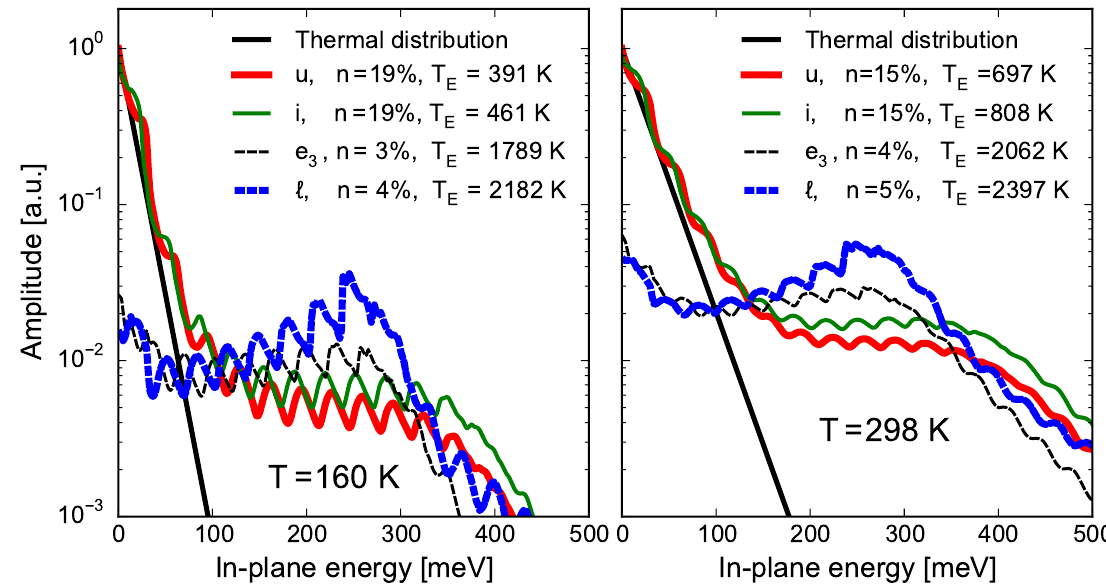
Figure 5. In-plane electron energy distribution for the upper lasing level (u), lower lasing level ( (cid:96) ), injector (i), and the most important extractor ( e 3 ) state. Results are shown at the design lasing field (82 kV/cm) for lattice temperatures of 160 K (left) and 298 K (right). The solid black line shows the corresponding thermal equilibrium distribution e − E k / k B T for comparison. For each state, the corresponding occupation n (percentage of stage occupation) and the calculated electron temperature T E are given in the